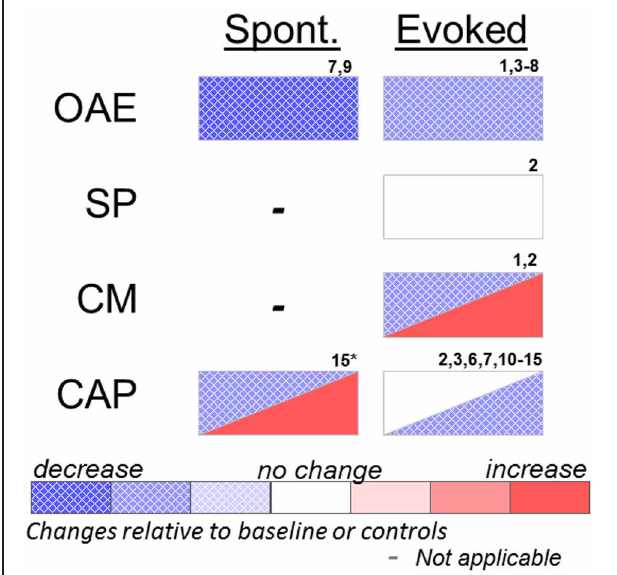
FIGURE 1 | Effects of systemic or cochlear perfusion of salicylate on spontaneous (Spont.) or sound-evoked (Evoked) cochlear measures. OAE, otoacoustic emissions; SP, summating potential; CM, cochlear microphonic; CAP, compound action potential. 1. Fitzgerald et al. (1993); 2. Puel et al. (1990); 3. Stolzberg et al. (2011); 4. Ruel et al. (2008); 5. Ralli et al. (2010); 6. Guitton et al. (2003); 7. Wier et al. (1988); 8. Janssen et al. (2000); 9. McFadden and Plattsmier (1984); 10. Muller et al. (2003); 11. Didier et al. (1993); 12. Silverstein et al. (1967); 13. Guitton et al. (2005); 14. Chen et al. (2010); 15. Cazals et al. (1998) ( ∗ spontaneous cochleoneural activity was decreased immediately after injection and increased on longer timescale; see